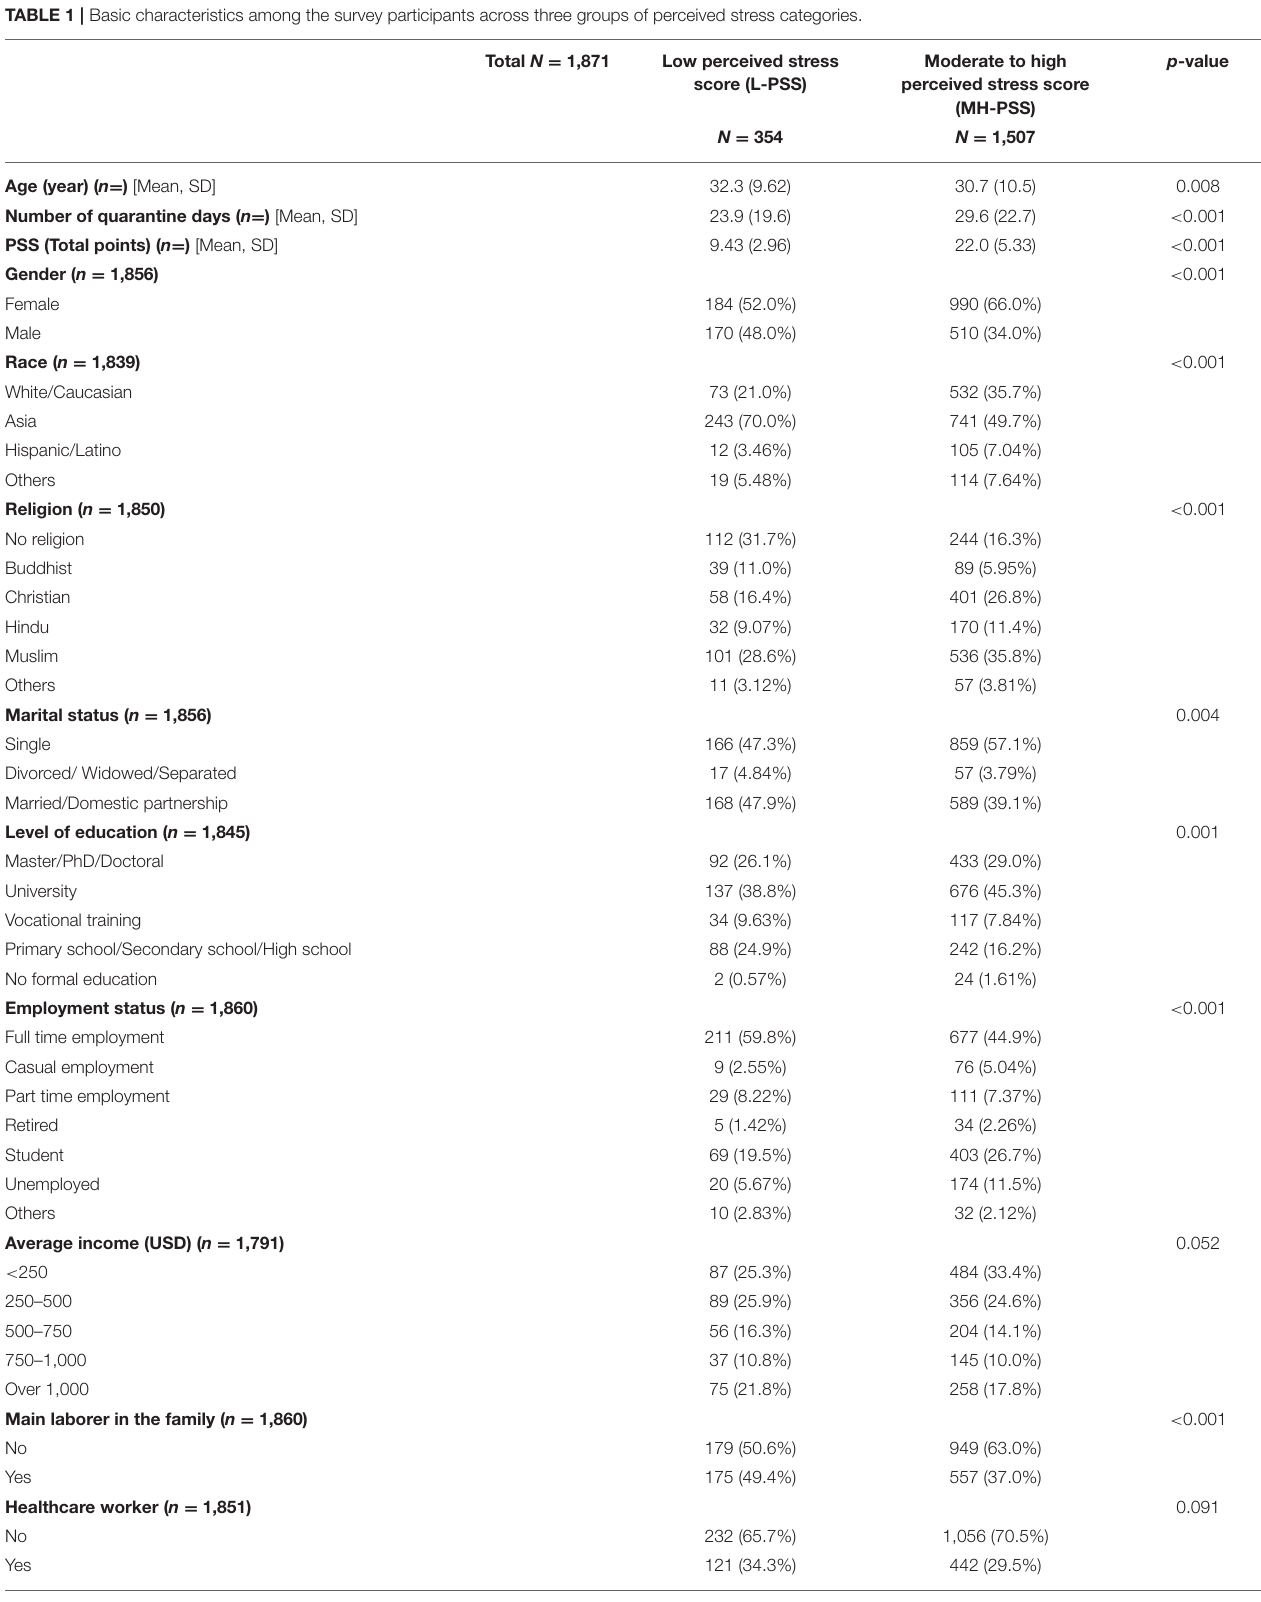
TABLE 1 | Basic characteristics among the survey participants across three groups of perceived stress